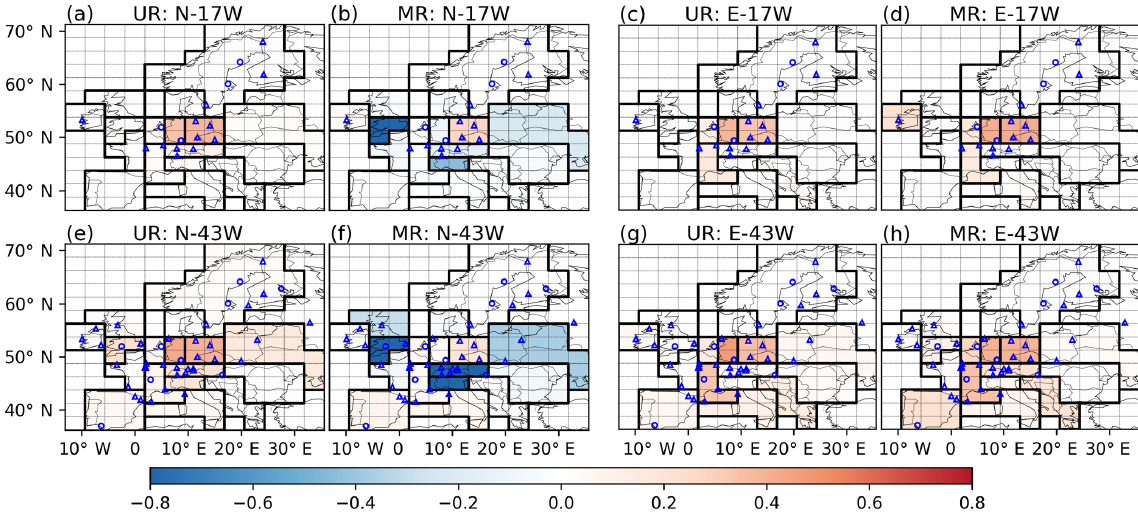
Figure 4. Average monthly uncertainty reductions and misfit reductions in FFCO 2 emissions over regions delineated by solid black lines, using the NET17 and NET43 networks and 2-week sampling for the inversions. The first and second columns are the results of INV-N inversions. The third and fourth columns are the results of INV-E inversions. The dashed lines show the grid cells of the transport model LMDZv4. The dots and triangles are the locations of the observation sites where the gradients are extracted with respect to the JFJ reference site. Dots (triangles) correspond to “urban” (or “rural”) stations defined in Sect. 2.1. A value of UR and MR closer to unity means a better performance of an inversion to constrain FFCO 2 emissions in a region.